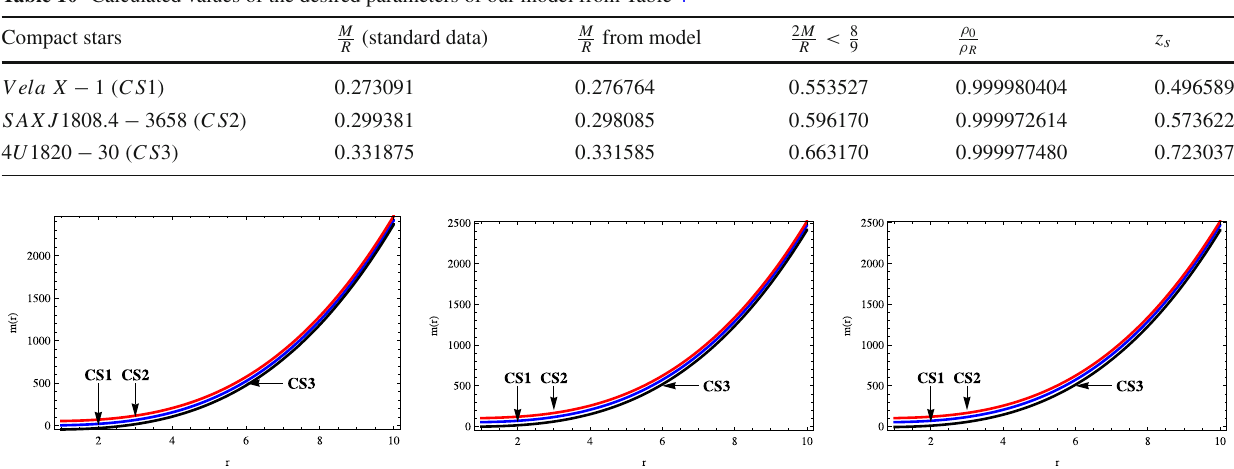
Table 10 Calculated values of the desired parameters of our model from Table 4 Compact stars M